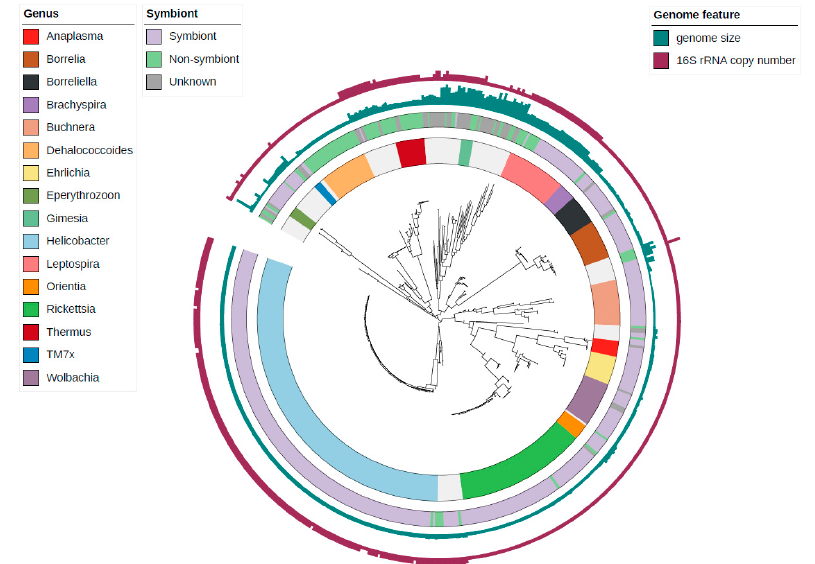
Figure 4. Features of each unlinked genome with phylogenetic tree. It was created in the “classify” process of GTDBtk and contained 574 unlinked genomes. The innermost strip-type circle represents clades conserved as unlinked at the genus level. The next outer circle indicates whether it was considered a symbiont of the genome, and if classification failed at the species level, it was marked as unknown. The outer two bar charts show the genome size and 16S rRNA copy number, respectively. In symbiotic bacteria, genomic features showed significantly different distribution between linked and unlinked genomes (Figure 5). Unlinked symbionts had higher genome adenine–thymine (AT) content, lower 16S rRNA copy number, and smaller genome size compared with linked symbionts, and the comparison of five genomic features used in the PCA plot showed significant differences between linked and unlinked genomes and between mixed genomes and unlinked genomes ( p < 0.001, Kruskal ‒ Wallis rank sum test and Dunn’s test). Among the genomic features of symbionts, the average of the whole genome AT contents was 64.9% in unlinked genomes, while averages of linked genomes and mixed genomes were 51.4% and 50.1%, respectively (Figure S1). Likewise, average AT contents of 16S rRNAs were also higher in unlinked symbionts than linked symbionts. AT-biased nucleotide composition, exhibited in reduced genomes of symbionts, is known to correlate to host ‒ symbiont co-speciation and accelerate molecular evolution [35,36]. The length of 16S and 23S rRNA was significantly different between linked symbionts and unlinked symbionts, but the correlation with rRNA operon linkage or symbiosis to the host is unclear (Figure S1).